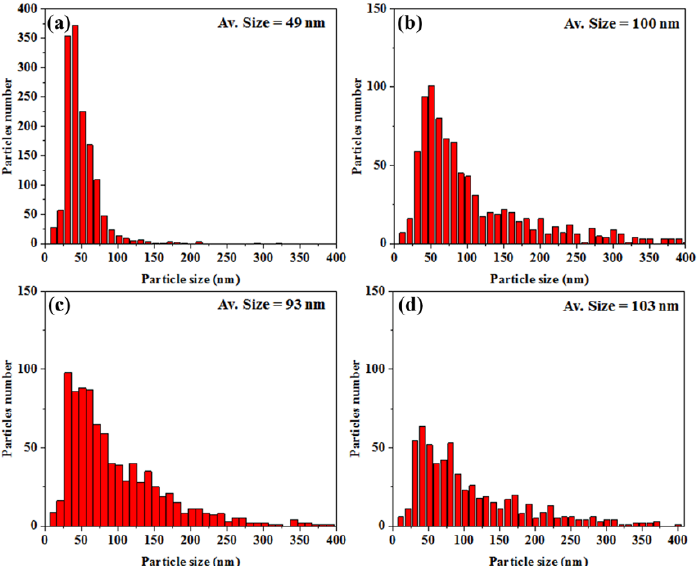
Figure 3. FESEM micrographs of samples fabricated using different synthesis conditions: ( a ) static synthesis using a 10 mM AgNO 3 solution at 20 °C; ( b ) static synthesis using a 100 mM AgNO 3 solution at 20 °C; ( c ) dynamic synthesis using a 10 mM AgNO 3 solution at 20 °C with a flow rate of 1 mL/min; ( d ) dynamic synthesis using a 100 mM AgNO 3 solution at 20 °C with a flow rate of 1 mL/min.